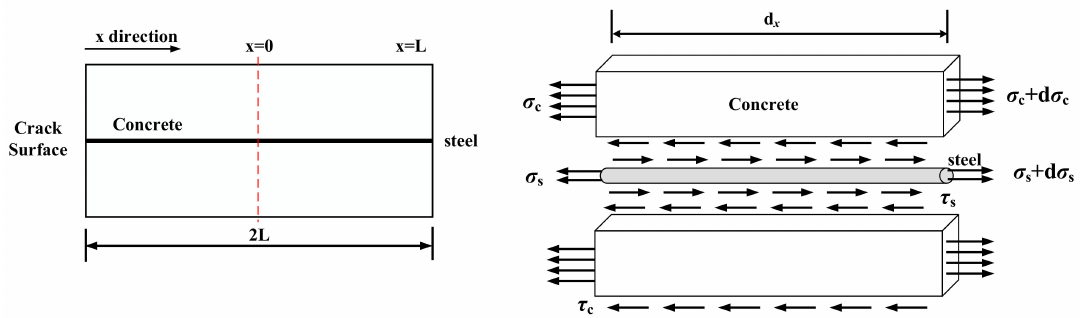
Figure 5. Analytical model for BFRP-CRCP (2 L is crack